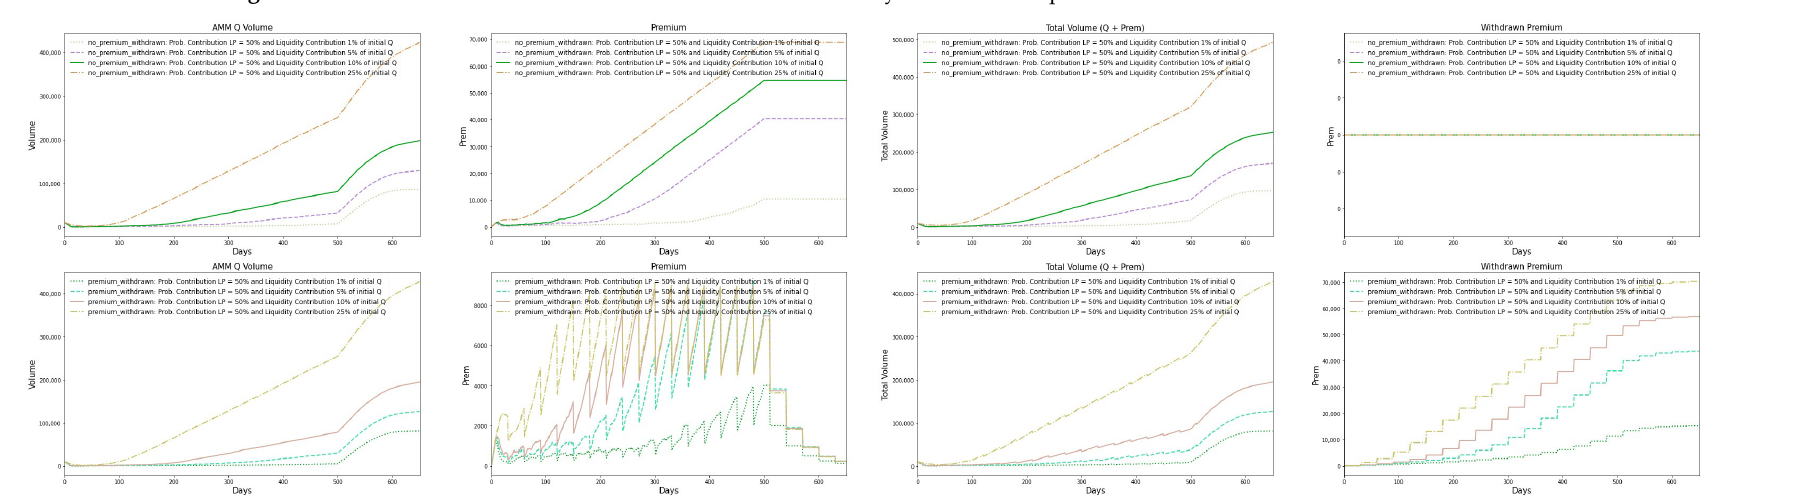
Figure A2. rkAMM Curves from simulation of scenario 1 and 30 days of withdrawal